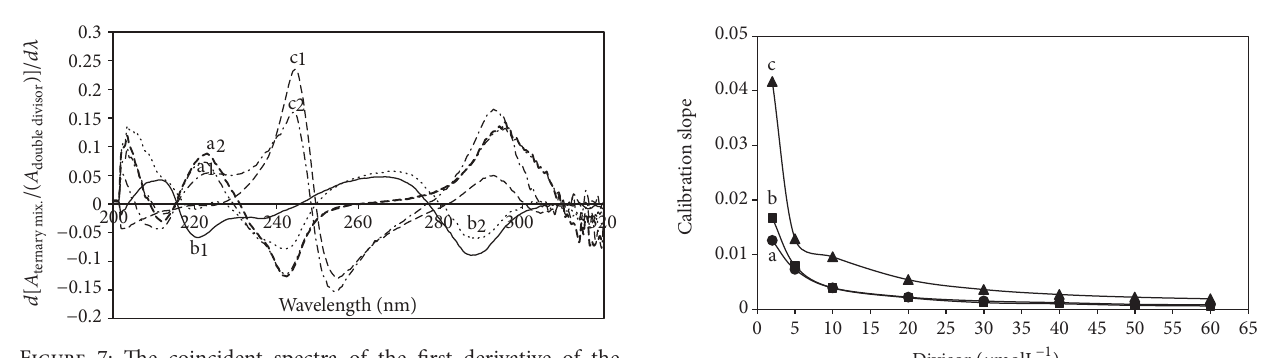
3.1. Optimization of the Parameters. In the following, the effective parameters involving pH, working wavelengths, and double devisor concentrations studied on the accuracy of the proposed method. 3.1.1. Optimization of pH. It has been shown that the maxi- mum absorbances for CAF and PAR are independent of the pH of the solution within the pH range of 1.8 to 11.0 in terms of sensitivity (Figure 6(a)). e maximum wavelengths for PAR and ASP are close to each other in the range of 1.8 to 8.0 but at pH